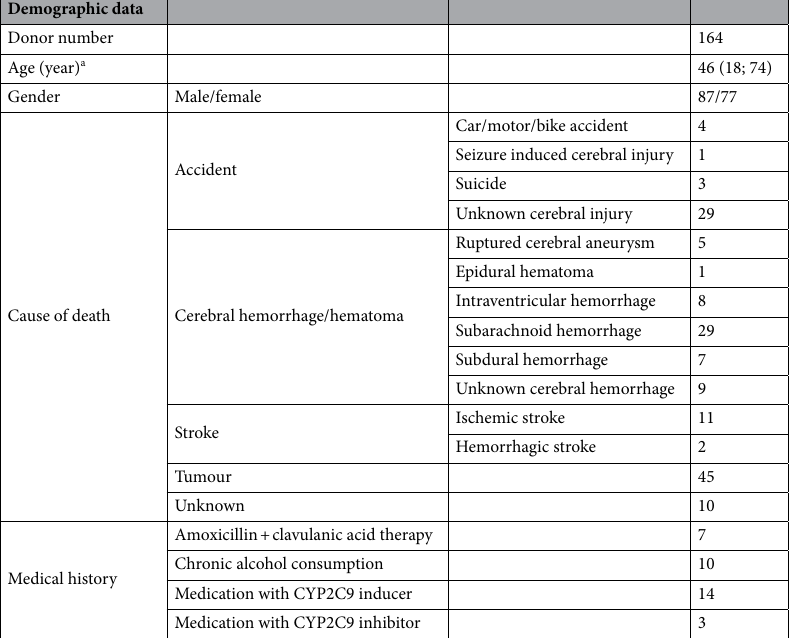
Table 1. Demographic data of the human organ donors. a Median (min;